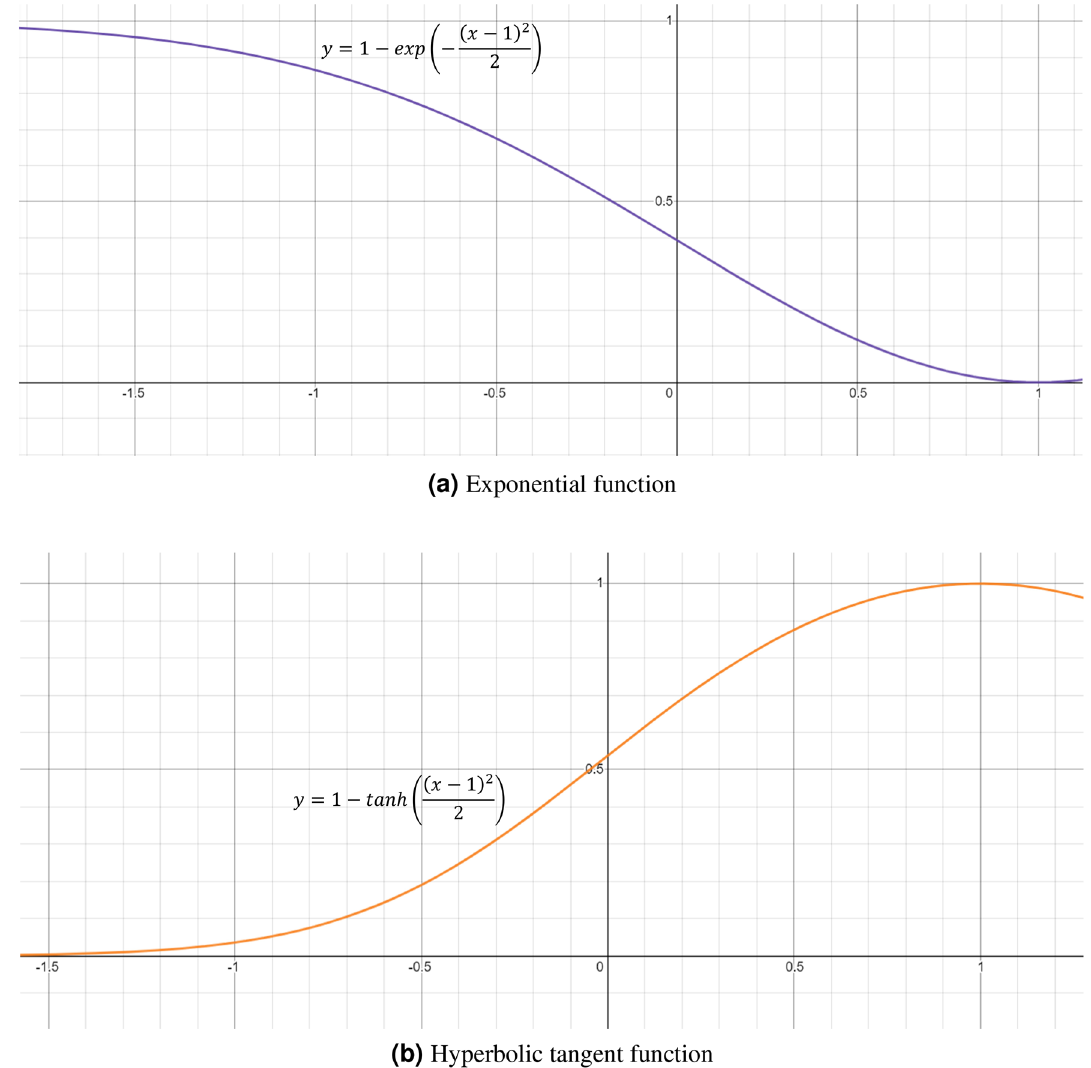
Figure 5. The non-linear functions used to generate fuzzy ranks in the proposed ensemble framework. x denotes the probability of a class of a sample data. (a) Quantifies the deviation from its objective for a class having prediction probability. Deviation decreases when x decreases. Eventually it becomes 0 when x = 1 .